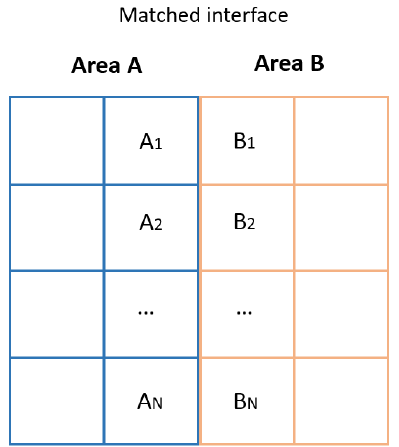
Figure 2. Schematic example of a grid with a matched interface.